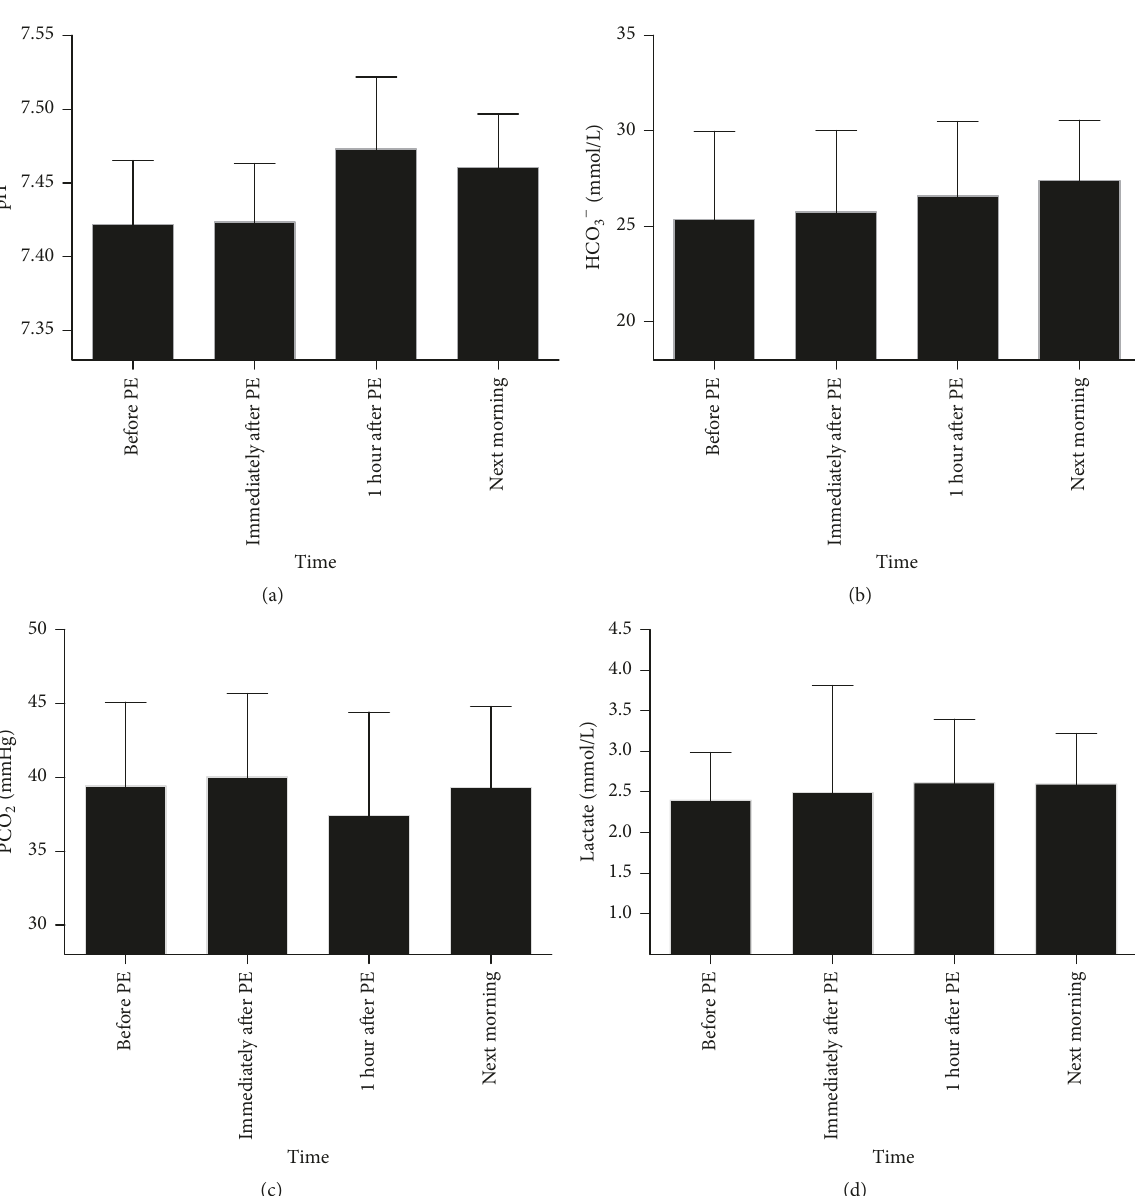
Figure 4: Trends of pH (a), standard bicarbonate (HCO 3− (b)), partial pressure of carbon dioxide (PCO 2 (c)), and lactate (d) during and after ALSS therapy for patients with